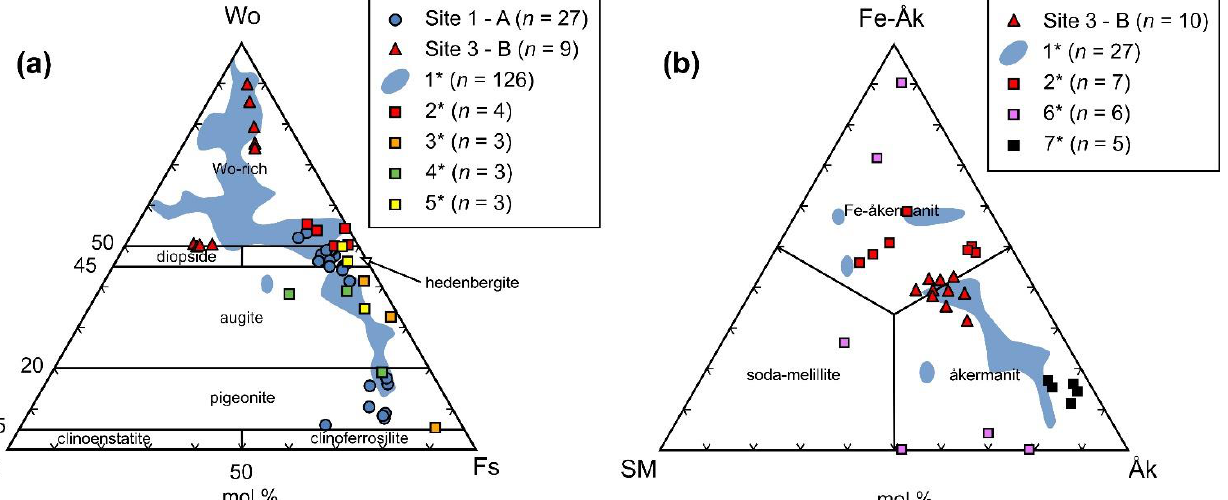
Table 4. Representative compositions of melilite and feldspar. The apfu values were calculated on the basis of 7 oxygens for melilite and 8 oxygens for feldspar. Av — average, b.d. — below the limit of detection, - not analysed.